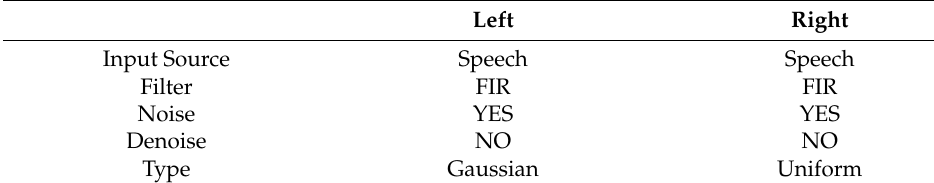
Table 3. Simulation parameters of scenario 2.